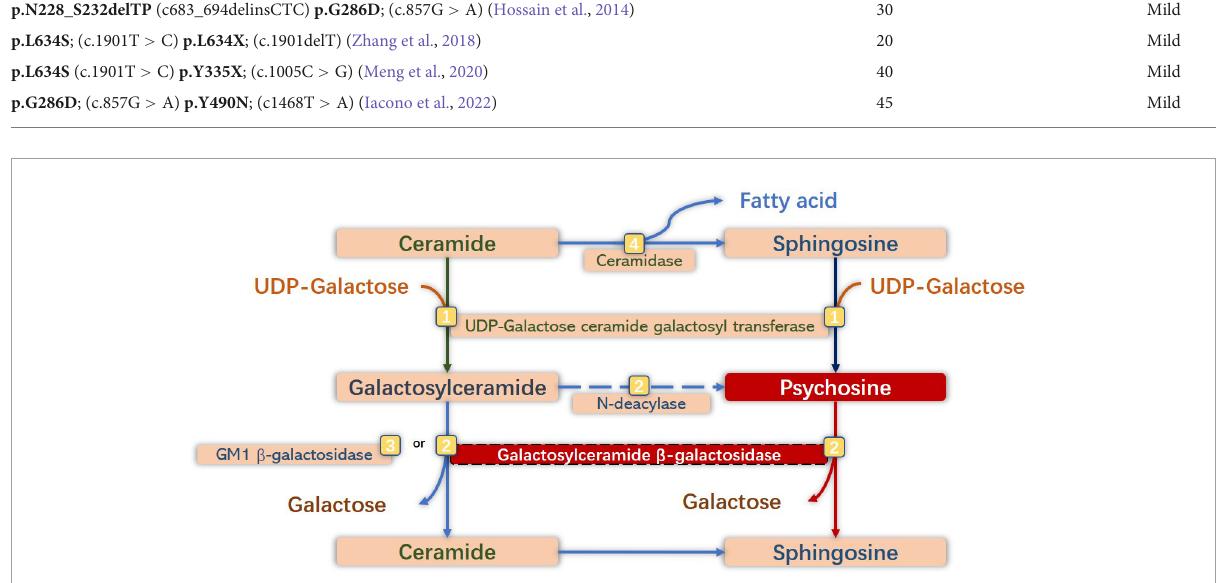
FIGURE2 Anabolic and catabolic pathways of galactosylsphingosine [psychosine (PSY)] and galactosylceramide. Galactosylceramide is one of the significant glycosphingolipids of oligodendrocytes (OLs) and Schwann cells, which is synthesized by galactosylation of ceramide by UDP-galactose ceramide galactosyl transferase (UDP-galactose CGT) (Graziano and Cardile, 2015), and is degraded to ceramide by degalactosylation by both galactosylceramide β -galactosidase (GALC) (Duffner et al., 2009a) and GM1 β -galactosidase (Duffner et al.,